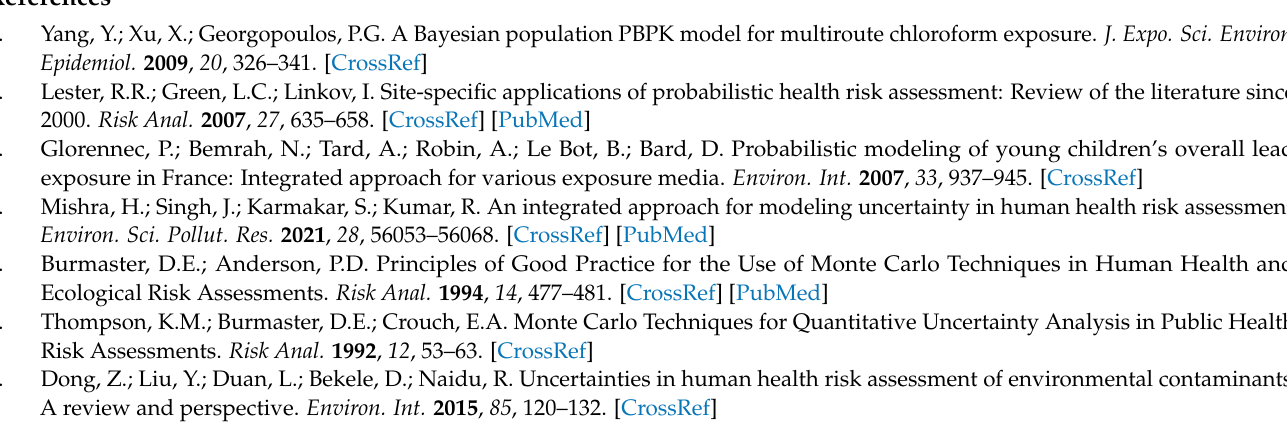
and local population, Figure S2: Correlation between IR and BW in participants, Figure S3: Rela- tionship between inhalation rate and body weight by traditional Monte Carlo simulation, Table S1: Toxicity equivalency factors (TEFs) and reference dose for the PAHs [49], Table S2: Estimation of BMR (basal metabolic rate) of population in Taiyuan, Text S1: Estimation of inhalation rate